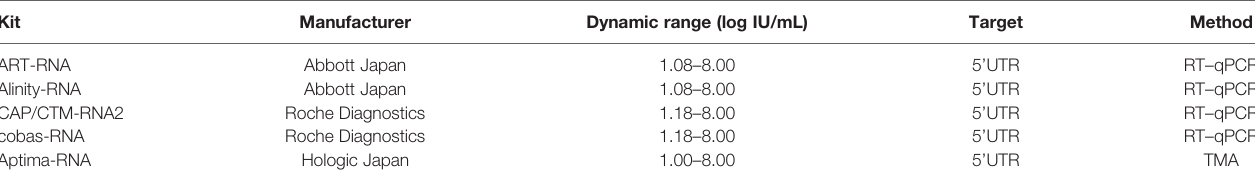
TABLE 3 | HCV RNA quanti fi cation kits evaluated in this